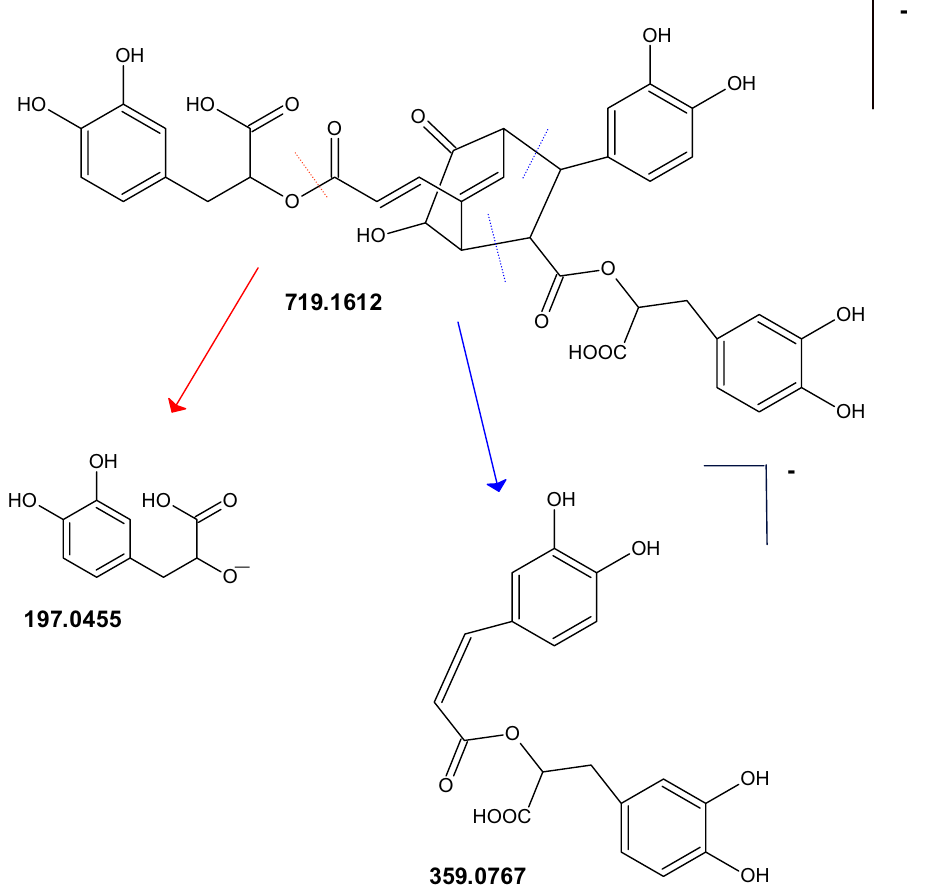
Figure 2. Proposed fragmentation of clerodendranoic acid